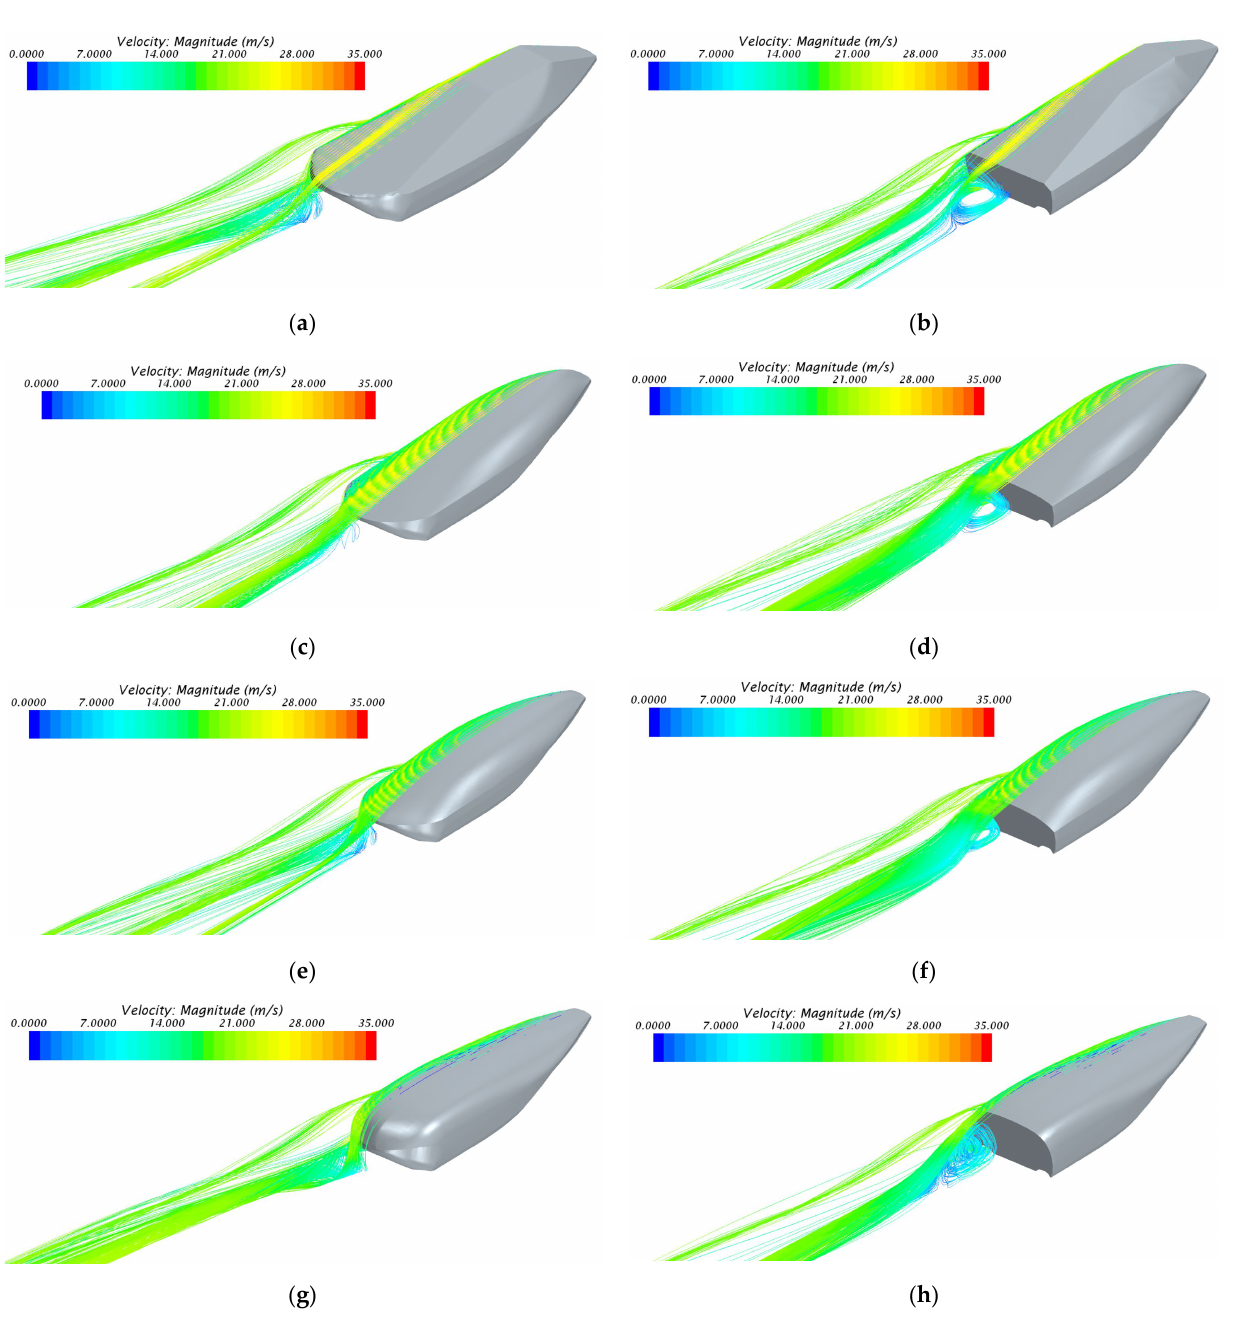
Figure 11. Streamline diagram of each model surface at 25 m/s: ( a ) Model A01; ( b ) Model A02; ( c ) Model B01; ( d ) Model B02; ( e ) Model C01; ( f ) Model C02; ( g ) Model D01; and ( h ) Model D02.